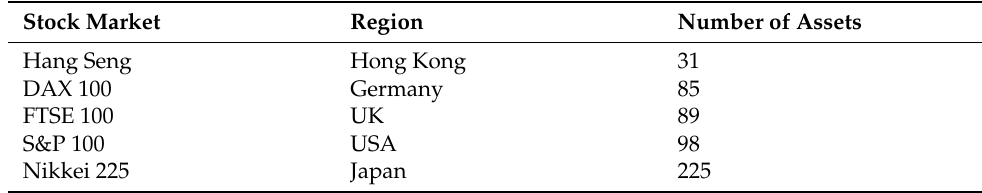
Table 2. Summary of the OR Library datasets for portfolio optimization. Stock